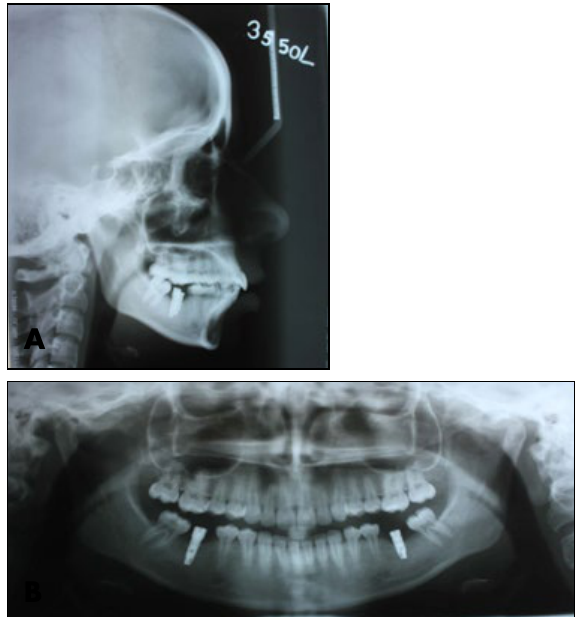
Figure 7 (a, b). Post-treatment lateral cephalogram and orthopantomogram.